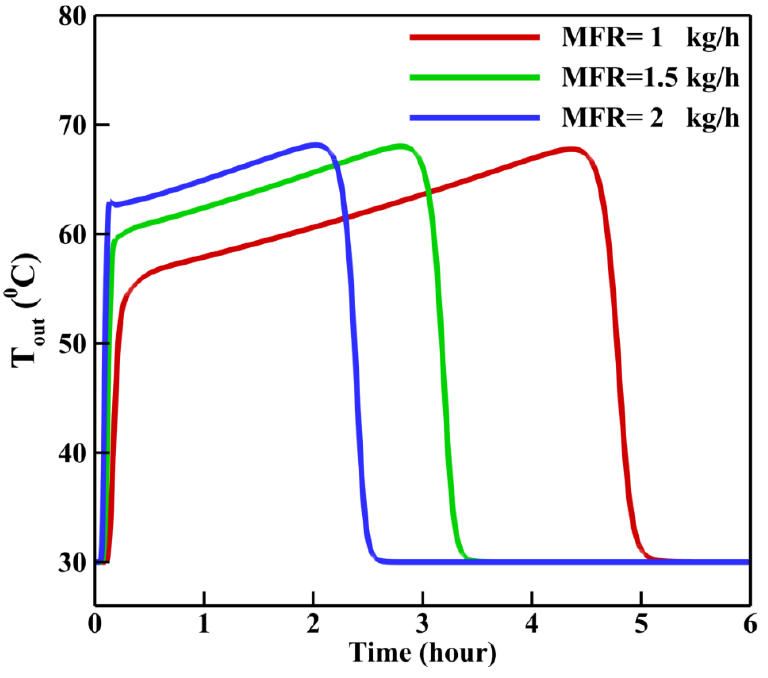
Figure 6. Outlet temperature under a different mass flow rate of incoming air at partial pressure of 15 mbar .